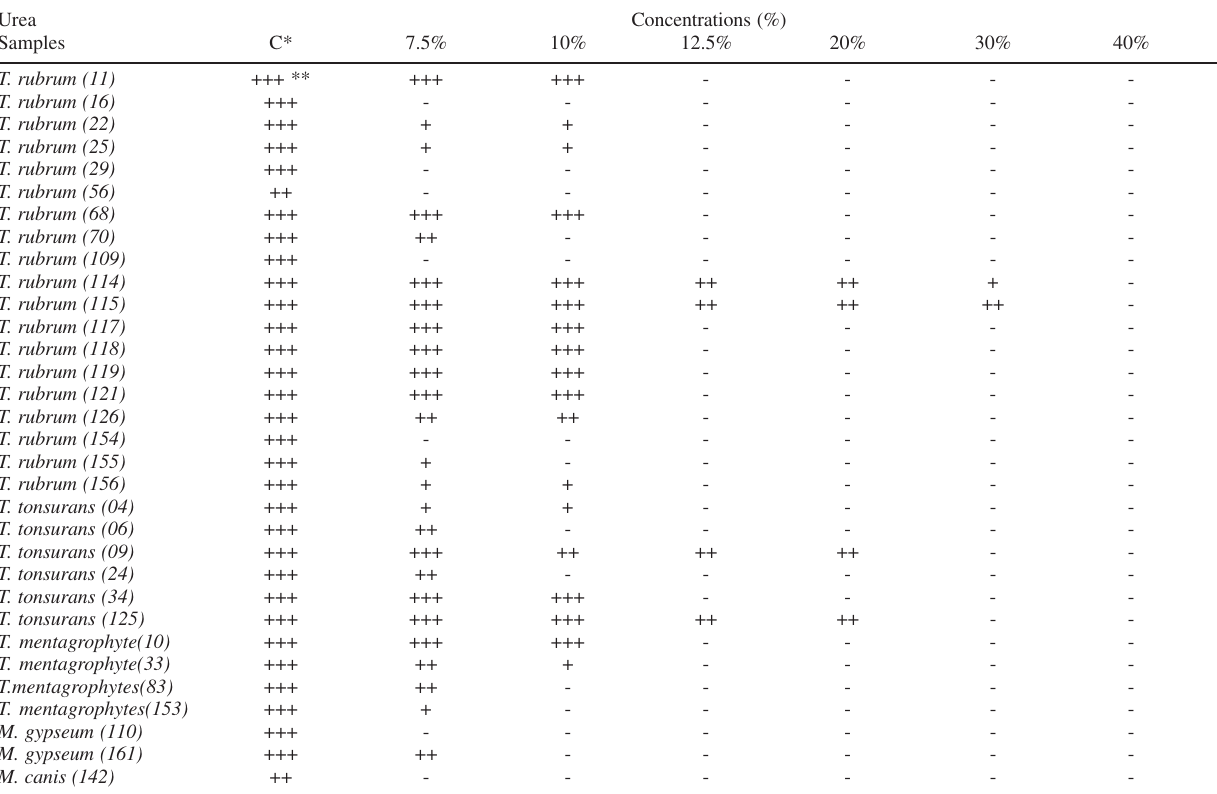
Table 2 - Growth index of 31 isolates of dermatophytes sown in Sabouraud-dextrose broth at 30°C in the presence of different concentrations of urea Urea